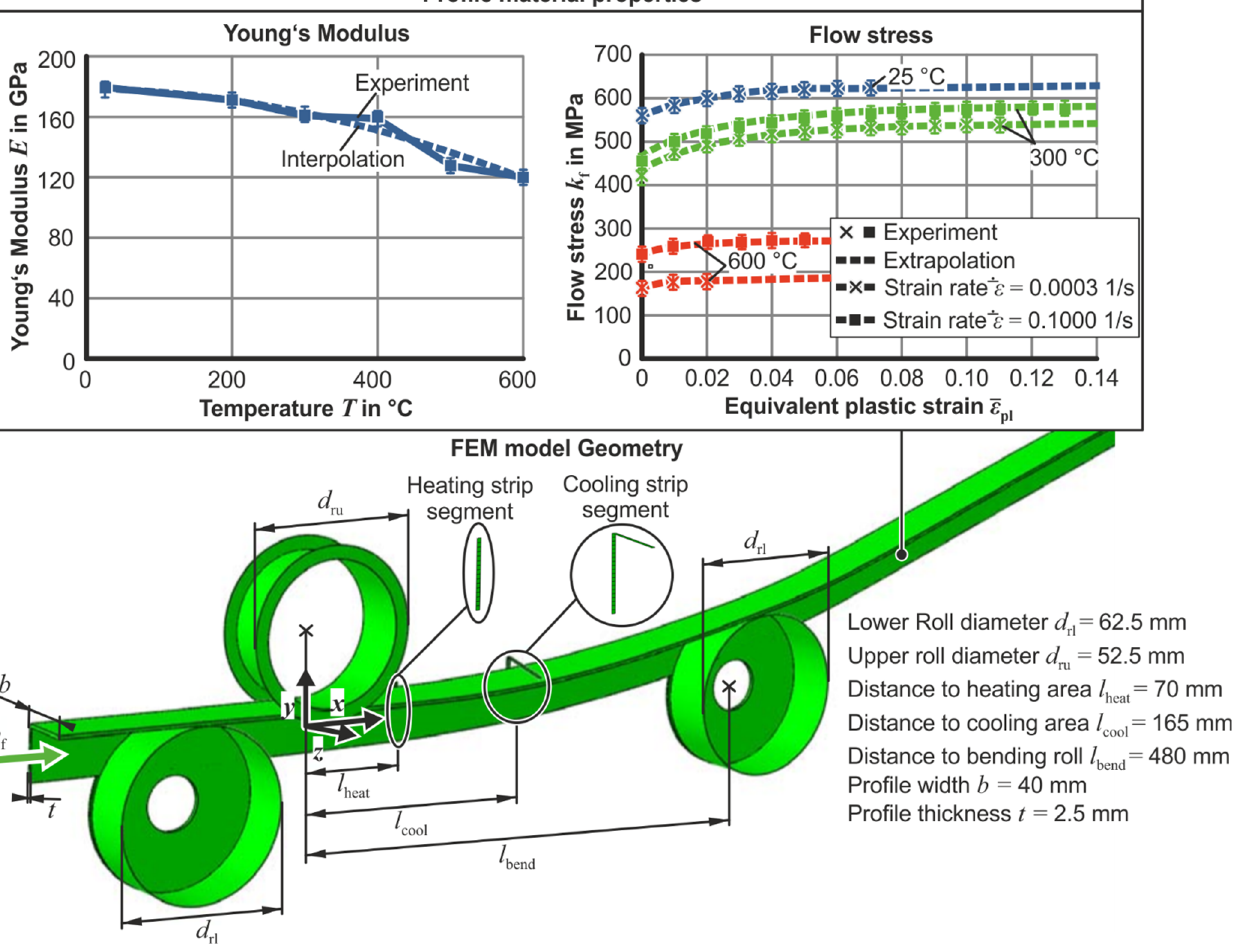
Figure 5. Simulation set-up with geometrical- and material parameters.